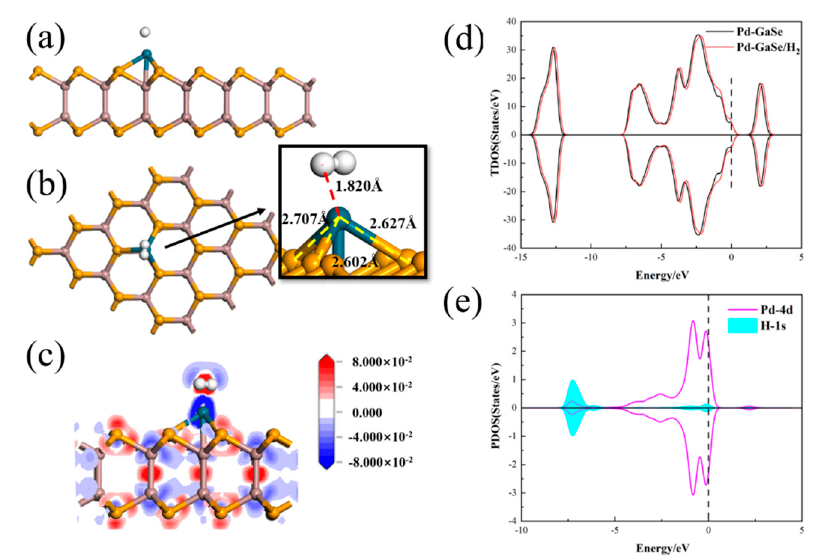
Figure 7. Adsorptive structure of Pd-GaSe/H 2 system ( a ) view of side, ( b ) view of top, ( c ) DCD distribution, ( d ) TDOS of Pd-GaSe/H 2 system, ( e ) PDOS of Pd-GaSe/H 2 system.